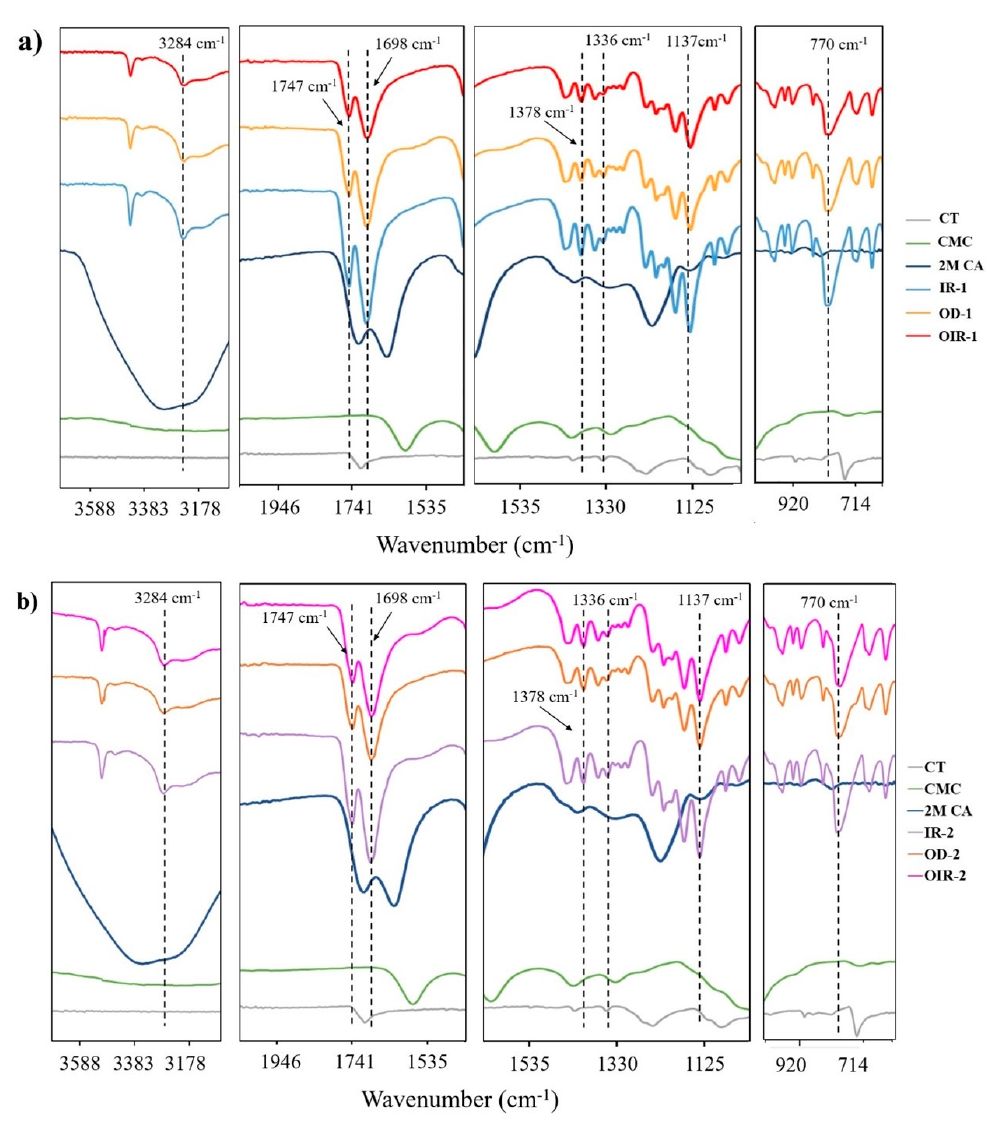
Figure 3. Enlargement of the FTIR spectra of ( a ) single-coated and ( b ) double-coated CMC cross- linked with 2M CA in different drying regimes.